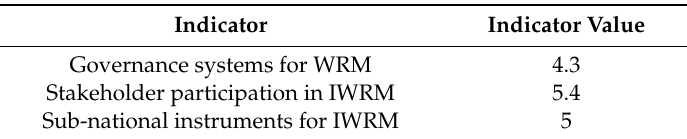
Table 1. Selected indicators from UNEP / DHI integrated and sustainable approach to water management (IWRM) Assessment in Mexico,